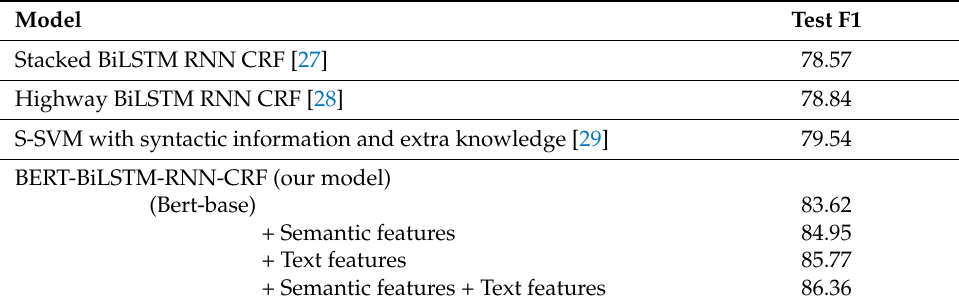
Table 1. F1 on the Korean PropBank benchmark with gold